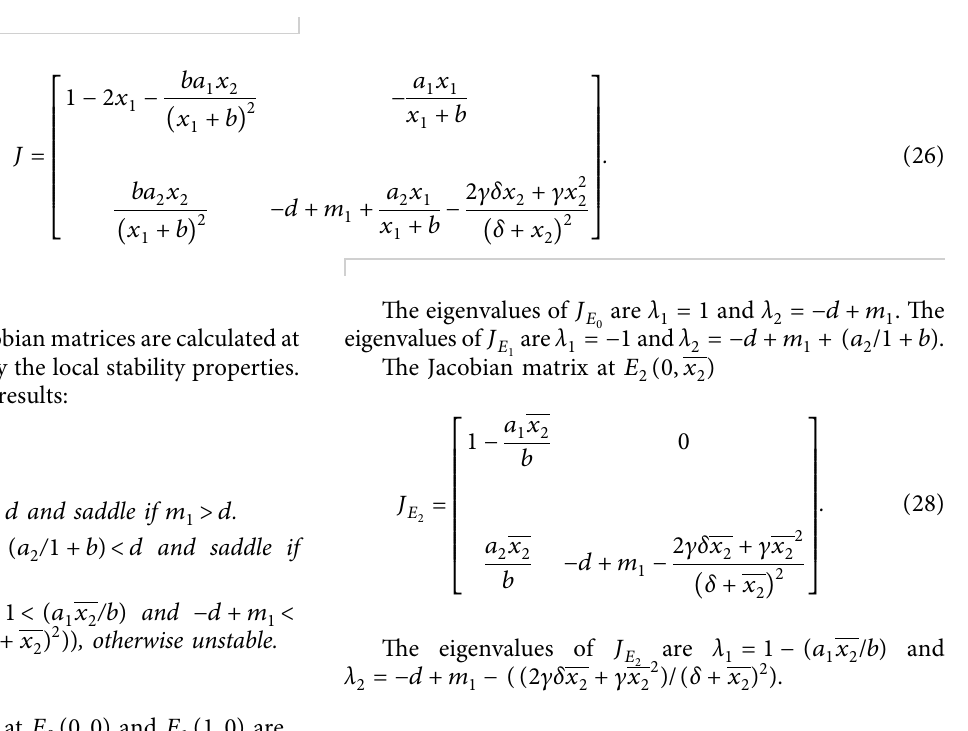
and c , where black line represents the prey nullcline and the colored lines represent the 1 , black dot implies E , colored dots implies E , and cyan boxed dots implies E ∗ . The parameter 0 1 2 � 0 . 5 ,b � 0 . 4 , d � 0 . 2 ,a � 0 . 5 , δ � 0 . 2, and m � 0 . 3 > d 1 2 1